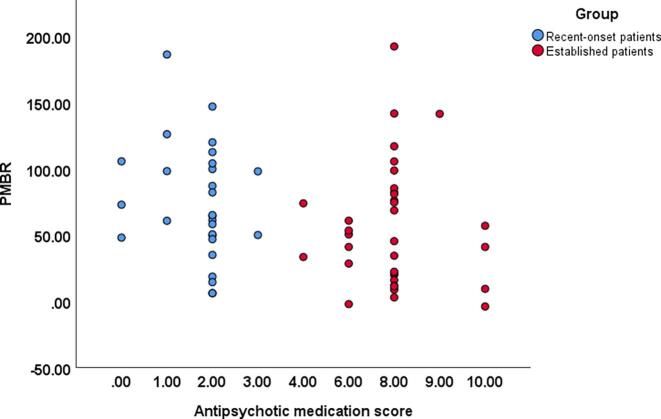
PMBR relationship with antipsychotic exposure score. The plot shows the relationship between the PMBR and antipsychotic medication score for recent-onset (RO; blue) and established patients (ES; red). (For interpretation of the references to colour in this figure legend, the reader is referred to the web version of this article.)